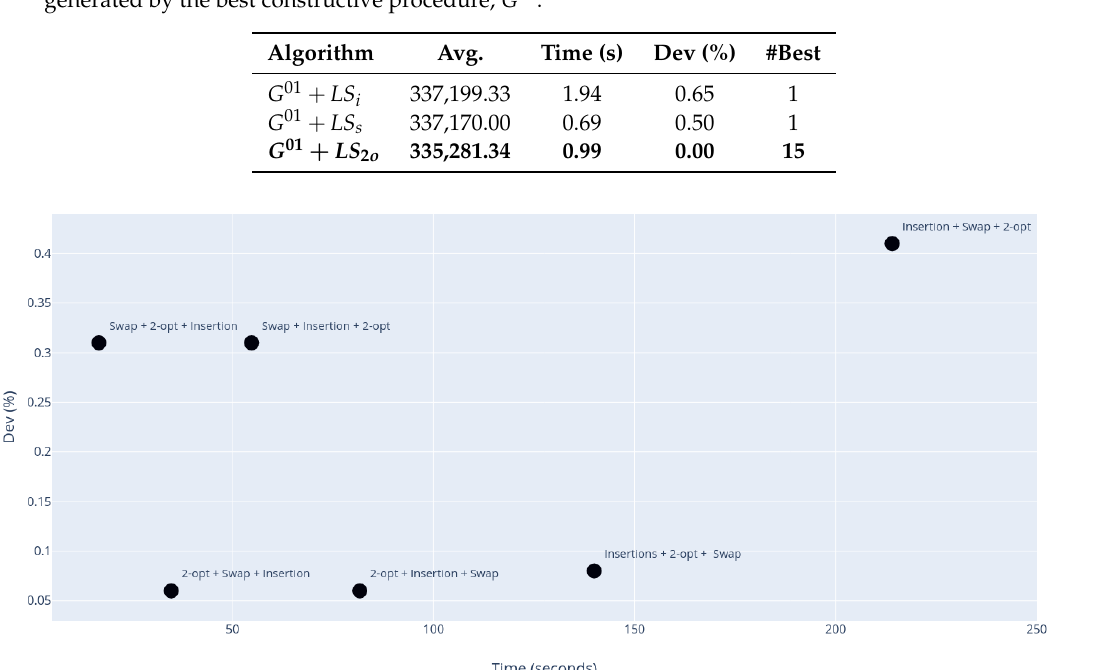
Figure 3. Time versus deviation graph for the different orderings of the local search inside the Variable Neighborhood Descent (VND)